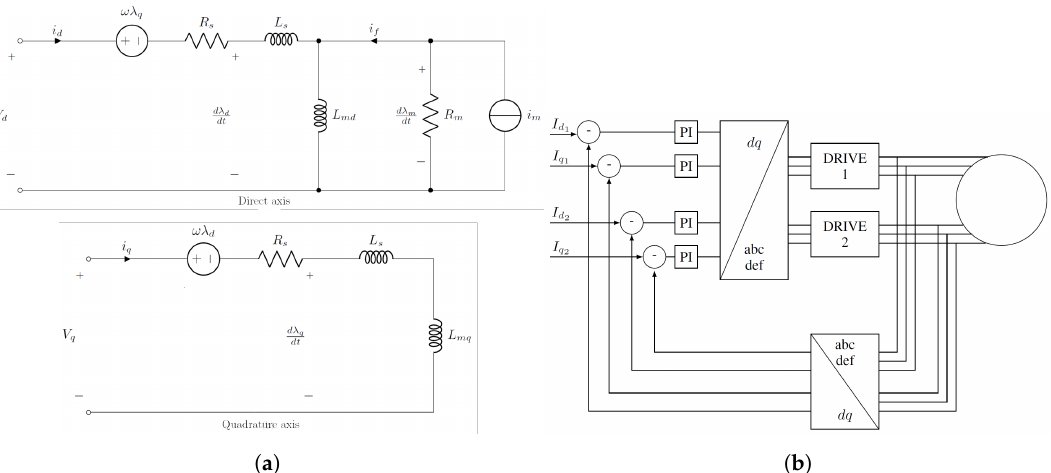
Figure 7. ( a ) Rotating reference frame equivalent circuits of the studied machine and ( b ) diagram of the employed control scheme.